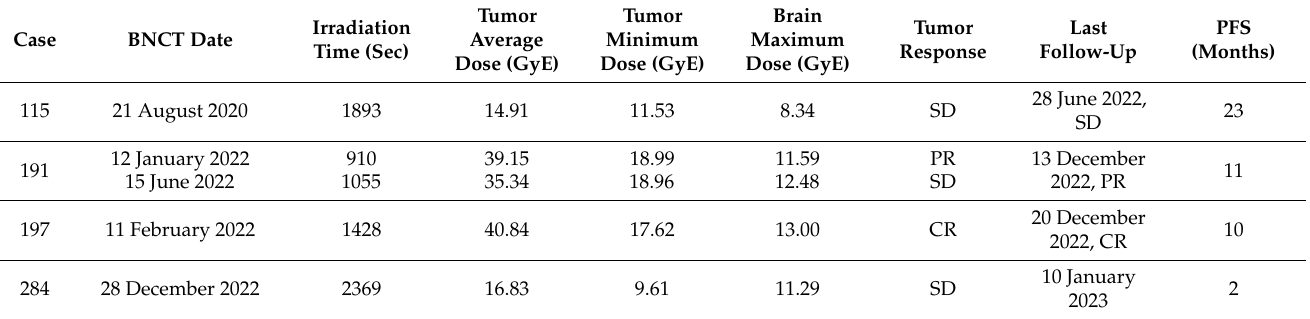
Table 1. Final dose report of Boron Neutron Capture Therapy (BNCT) treatment and the treatment response categorized by the Response Evaluation Criteria in Solid Tumors (RECIST)